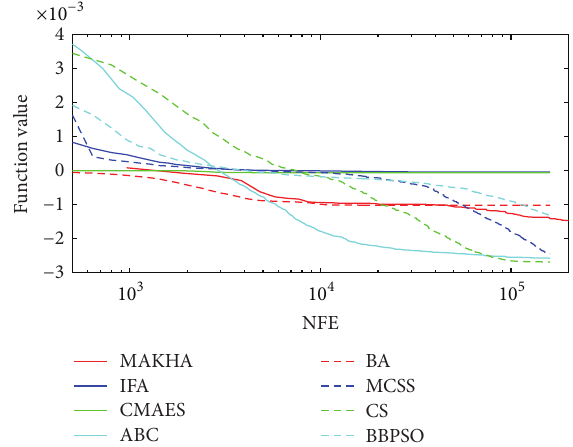
Figure 1: The evolution of the mean best value calculated via the eight metaheuristics versus NFE for problem T7.